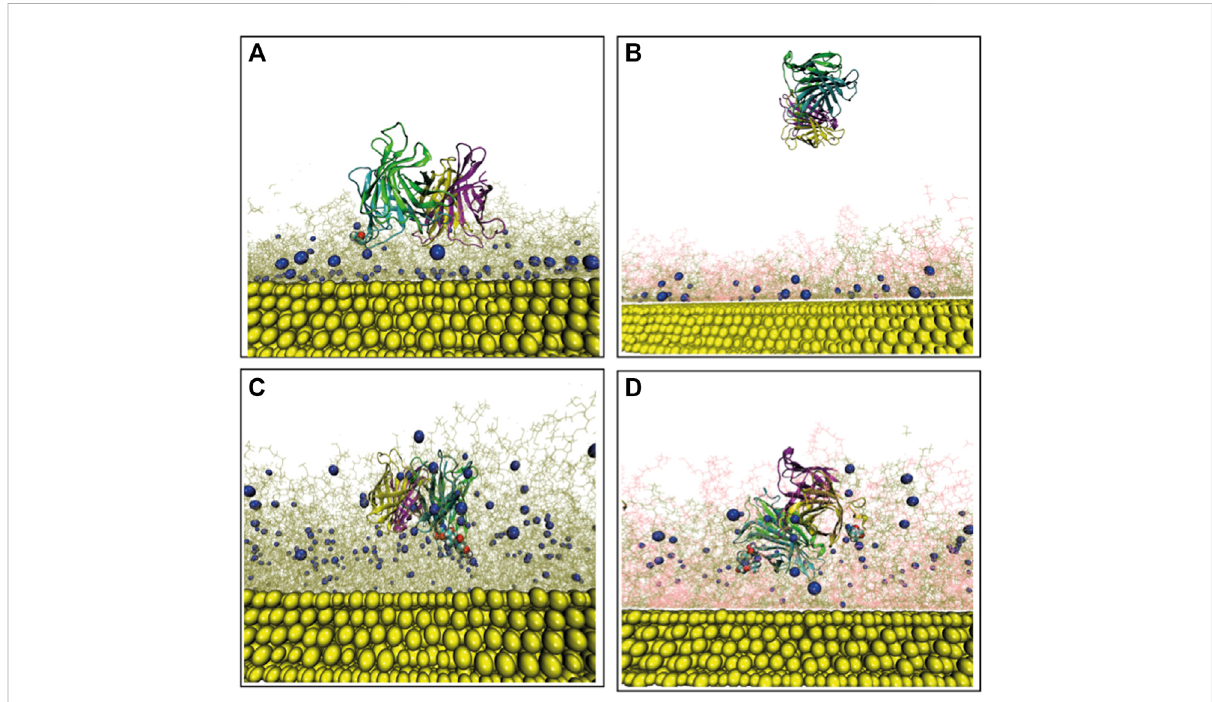
FIGURE 3 Final con fi guration of Streptavidin over four different surfaces as obtained after MD simulation and represented from the top as well as side views, terminal biotin atoms are shown by spherical representation (blue), Au (111) in yellow, PEGs are in pink, bPEGs in green, and the protein is shown in a cartoon representation with four different colors for tetramers, vdW spheres of proteins are the residues in proximity with bPEG/PEG in docked complex; (A) bPEG49; (B) bPEG25-PEG24; (C) bPEG98; (D)